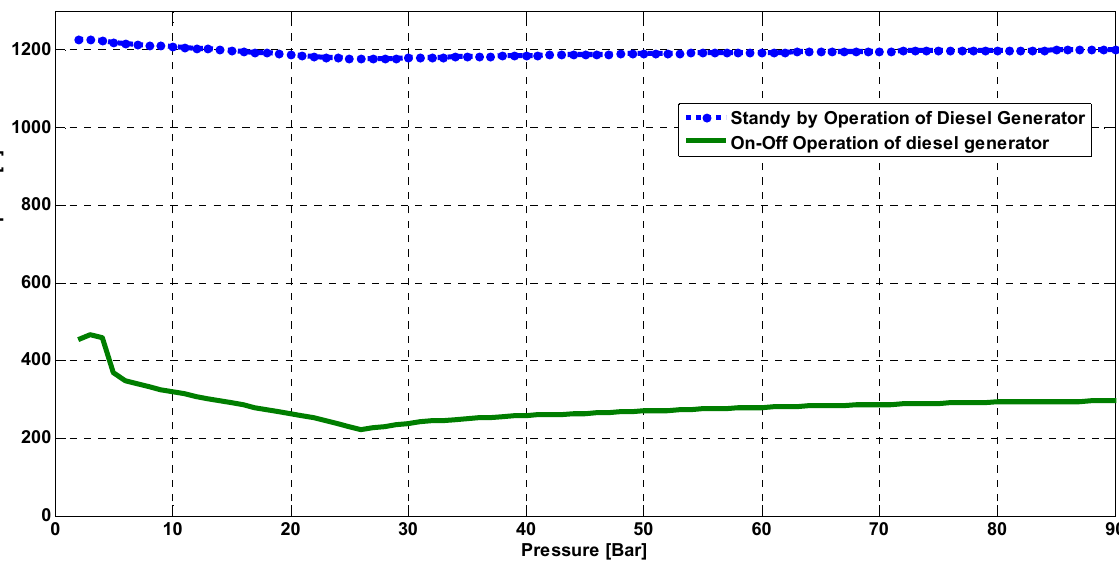
Figure 13. The DG fuel consumption in Standby and On-Off mode of